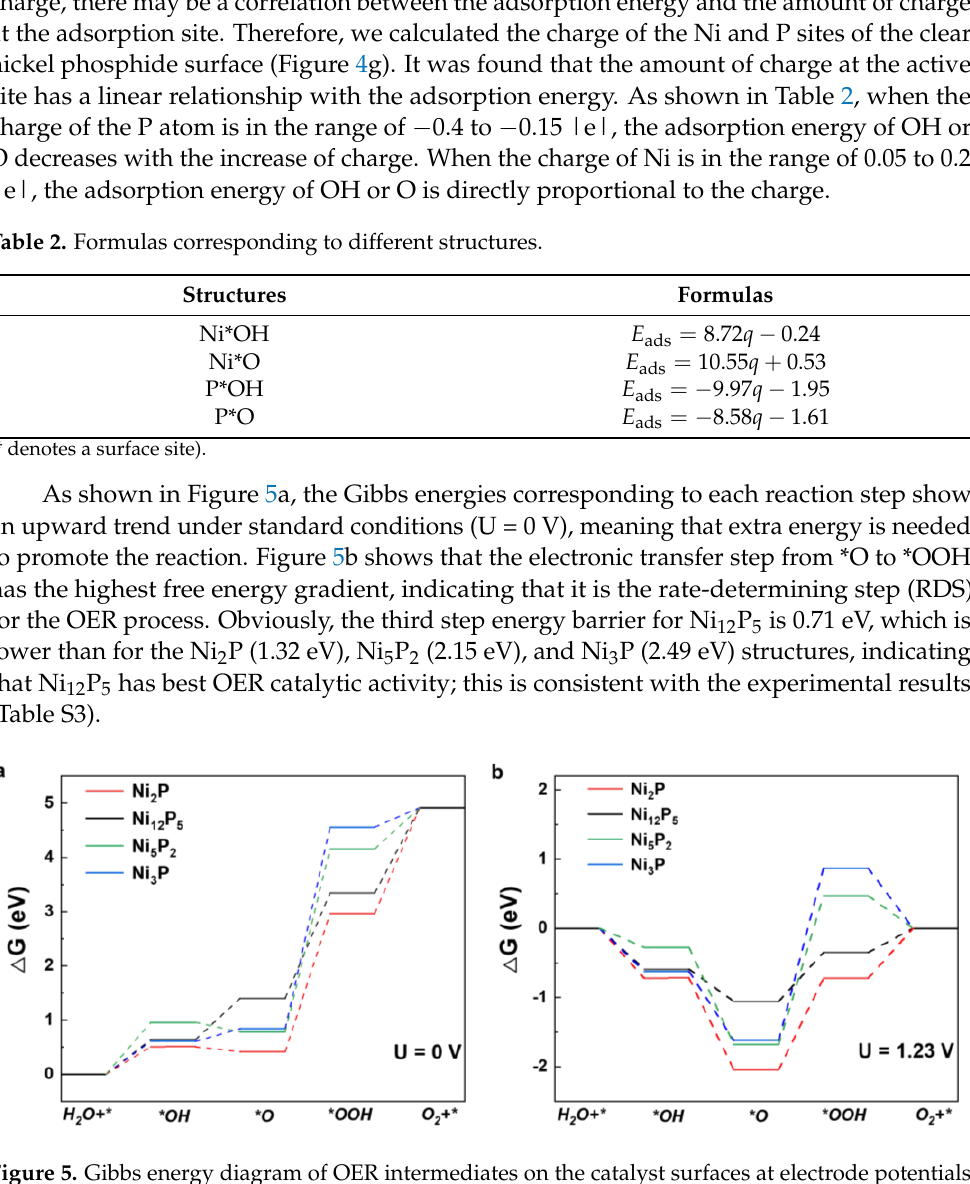
Figure 5. Gibbs energy diagram of OER intermediates on the catalyst surfaces at electrode potentials ( a ) U = 0 V and ( b ) U = 1.23